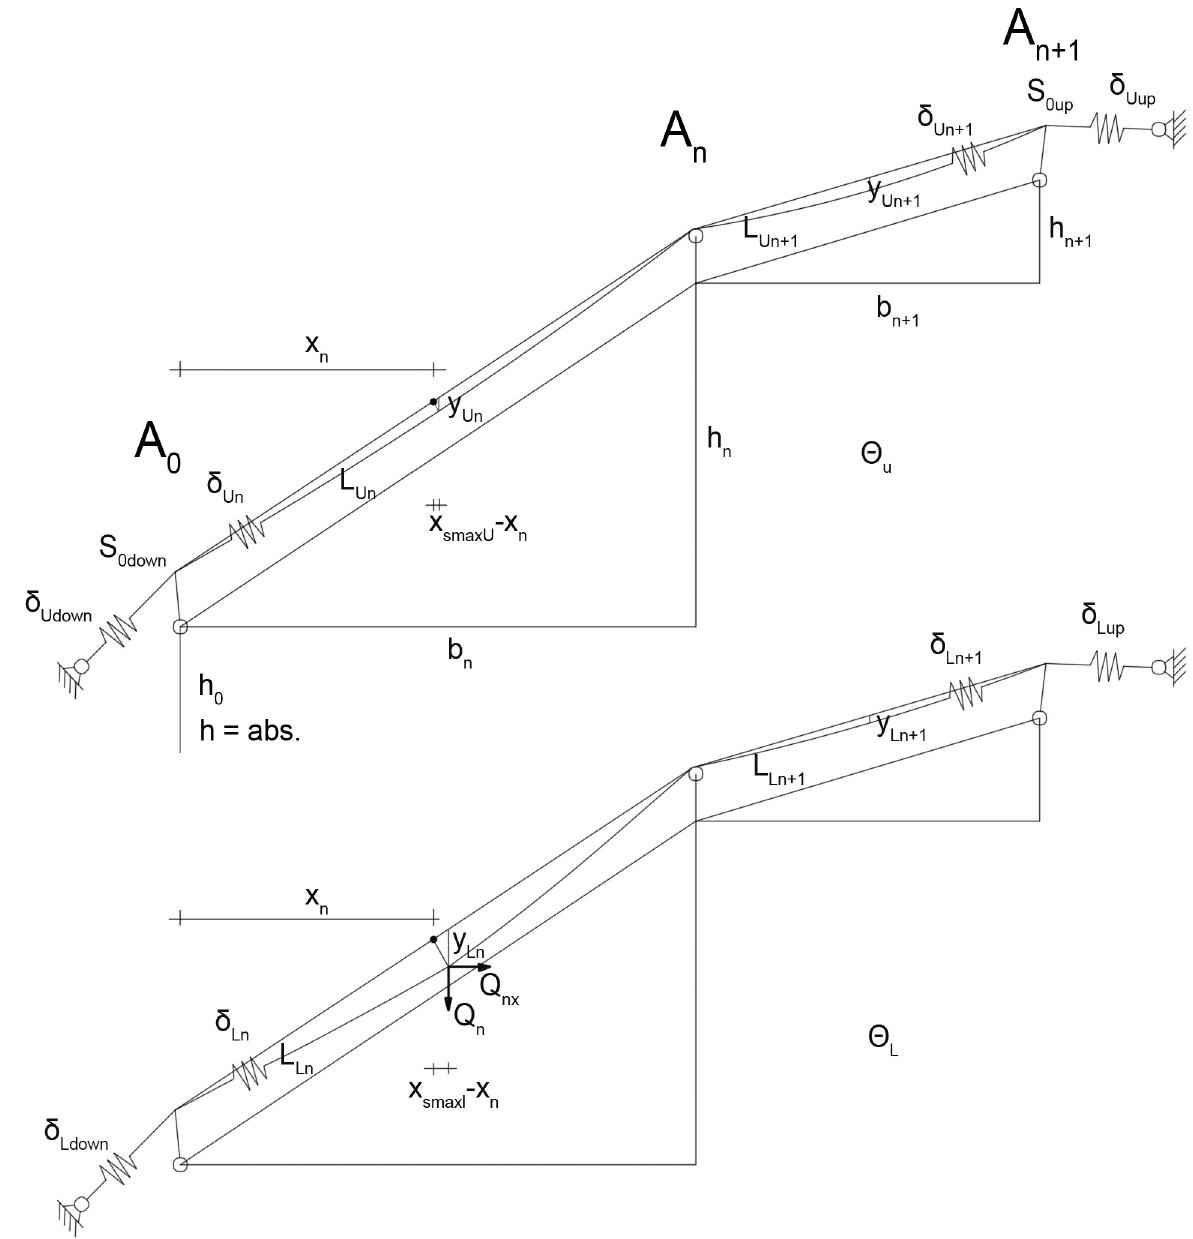
Fig 3. Definition of geometric